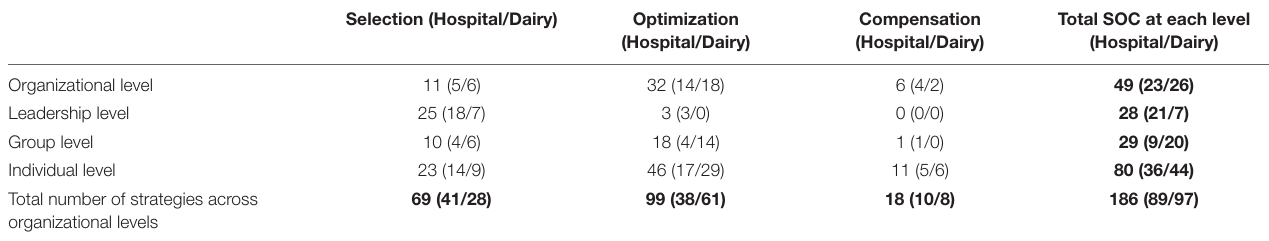
Selection (Hospital/Dairy) Optimization Compensation Total SOC at each level (Hospital/Dairy) (Hospital/Dairy)